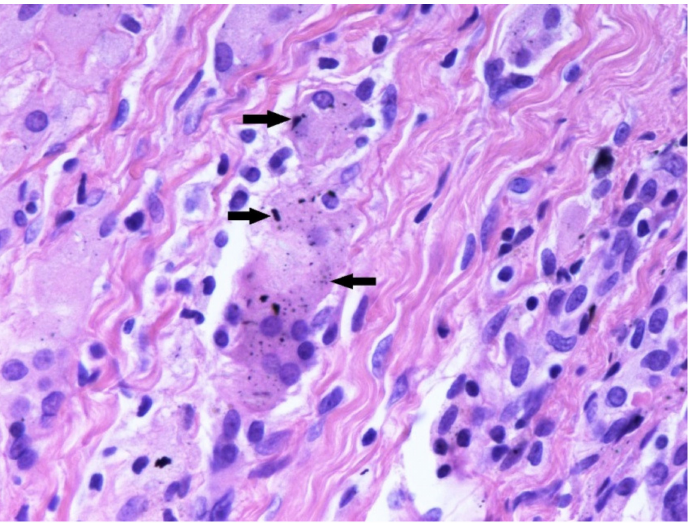
Figure 4. Tissue sample taken underneath the medial tibial baseplate at the revision surgery. Note dark-coloured metallic debris (black arrows). Haematoxylin and eosin (HE) × 400. Micro-PIXE elemental analysis confirmed the presence of metallic debris from the degraded tibial tray inside the analysed tissue slices. Figure 5 shows the elemental distribu- tion of Ta and Ti obtained with software GeoPIXE 7.5+ from a scanned tissue area of 1 mm 2 . The elemental maps show the large extended area containing metallic debris and the size distribution of debris up to 50 µ m per side for some Ta and Ti